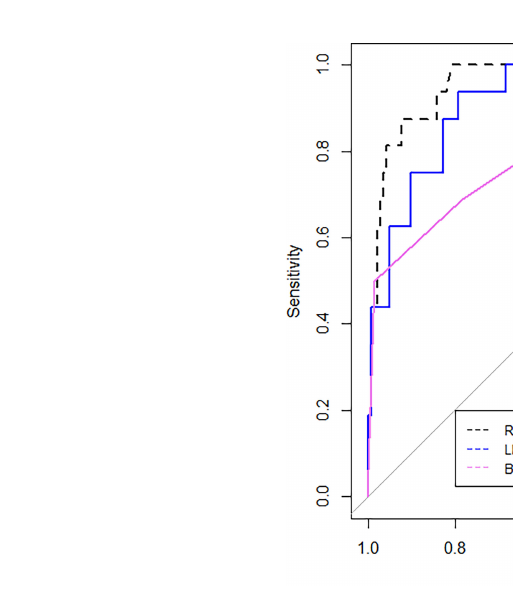
TABLE 3 | Diagnostic values of various models of SAP.